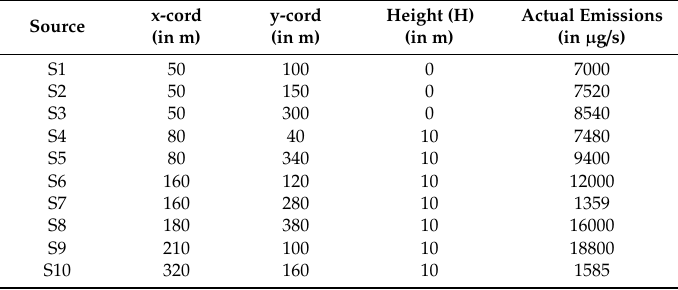
Table 1. Emissions assumed for each source.